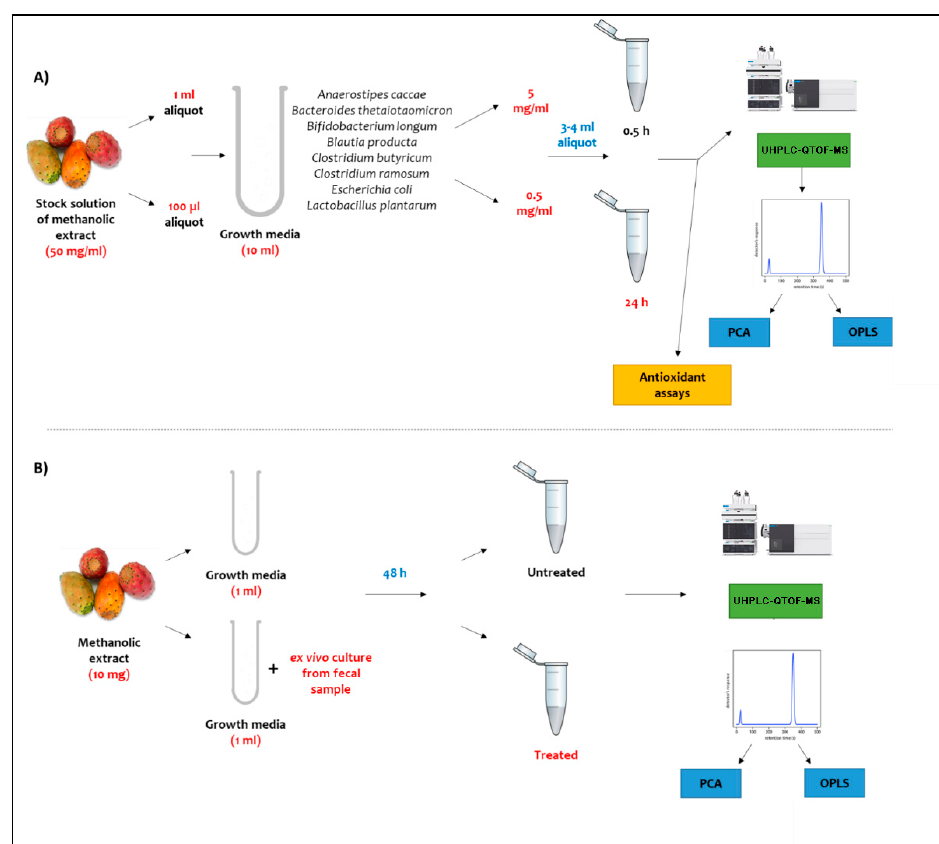
Figure 6. Schematic representation of the proposed ( A ) in vitro and ( B ) ex vivo protocol to assess the impact of gut microbiota on O. ficus metabolites.